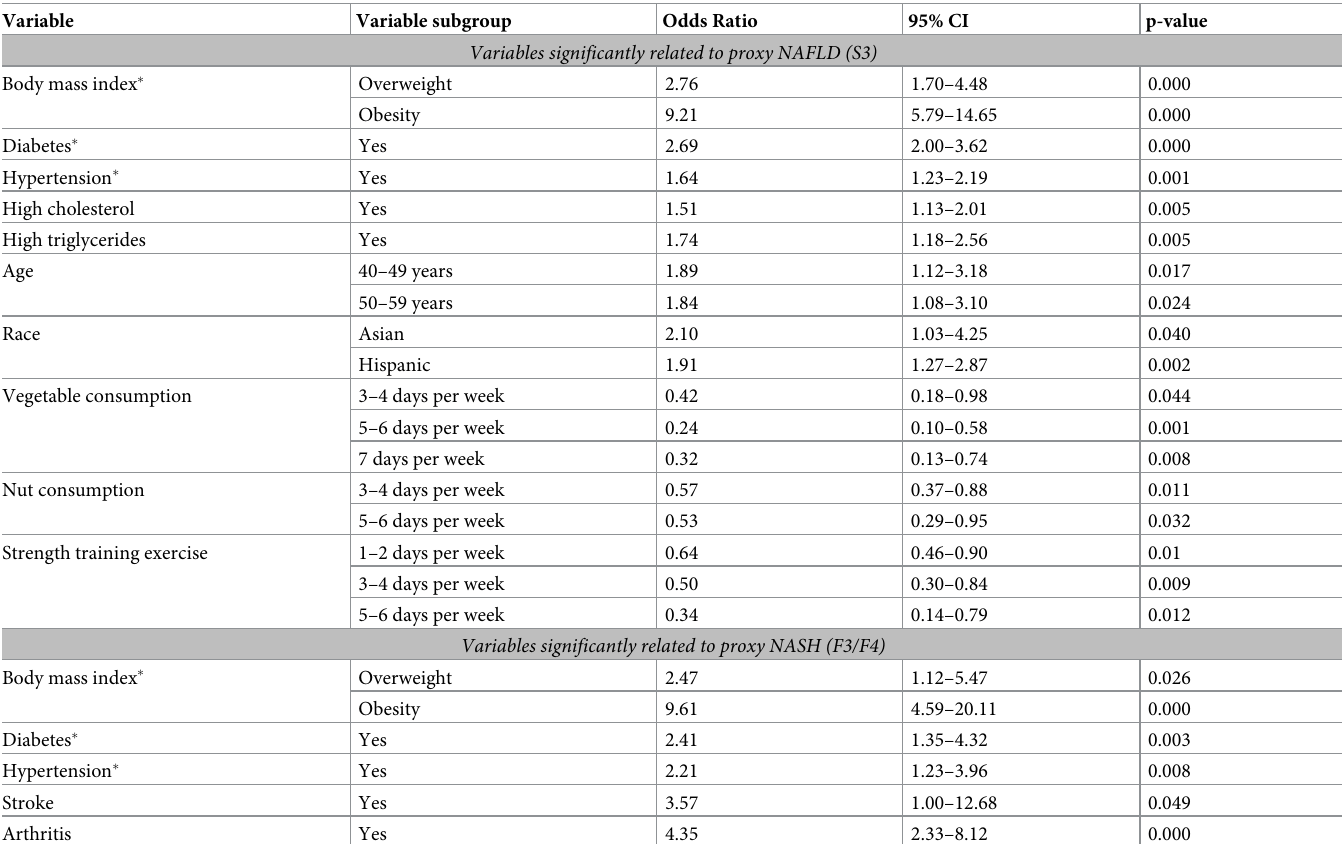
Table 7. Odds ratio analysis of statistically significant variables for TE and CAP